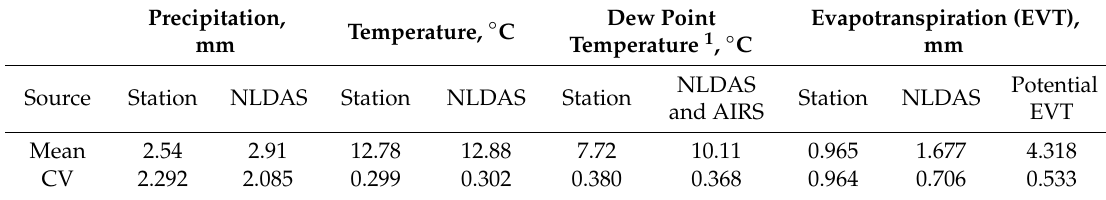
Table 5. Average daily data comparison between NASA data sources and climate